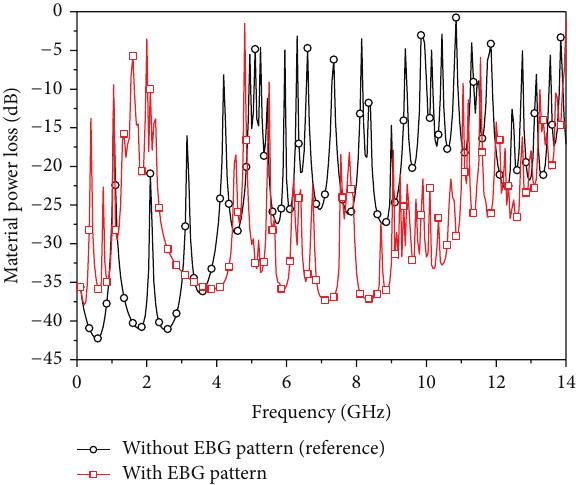
versus frequency for two setups LM